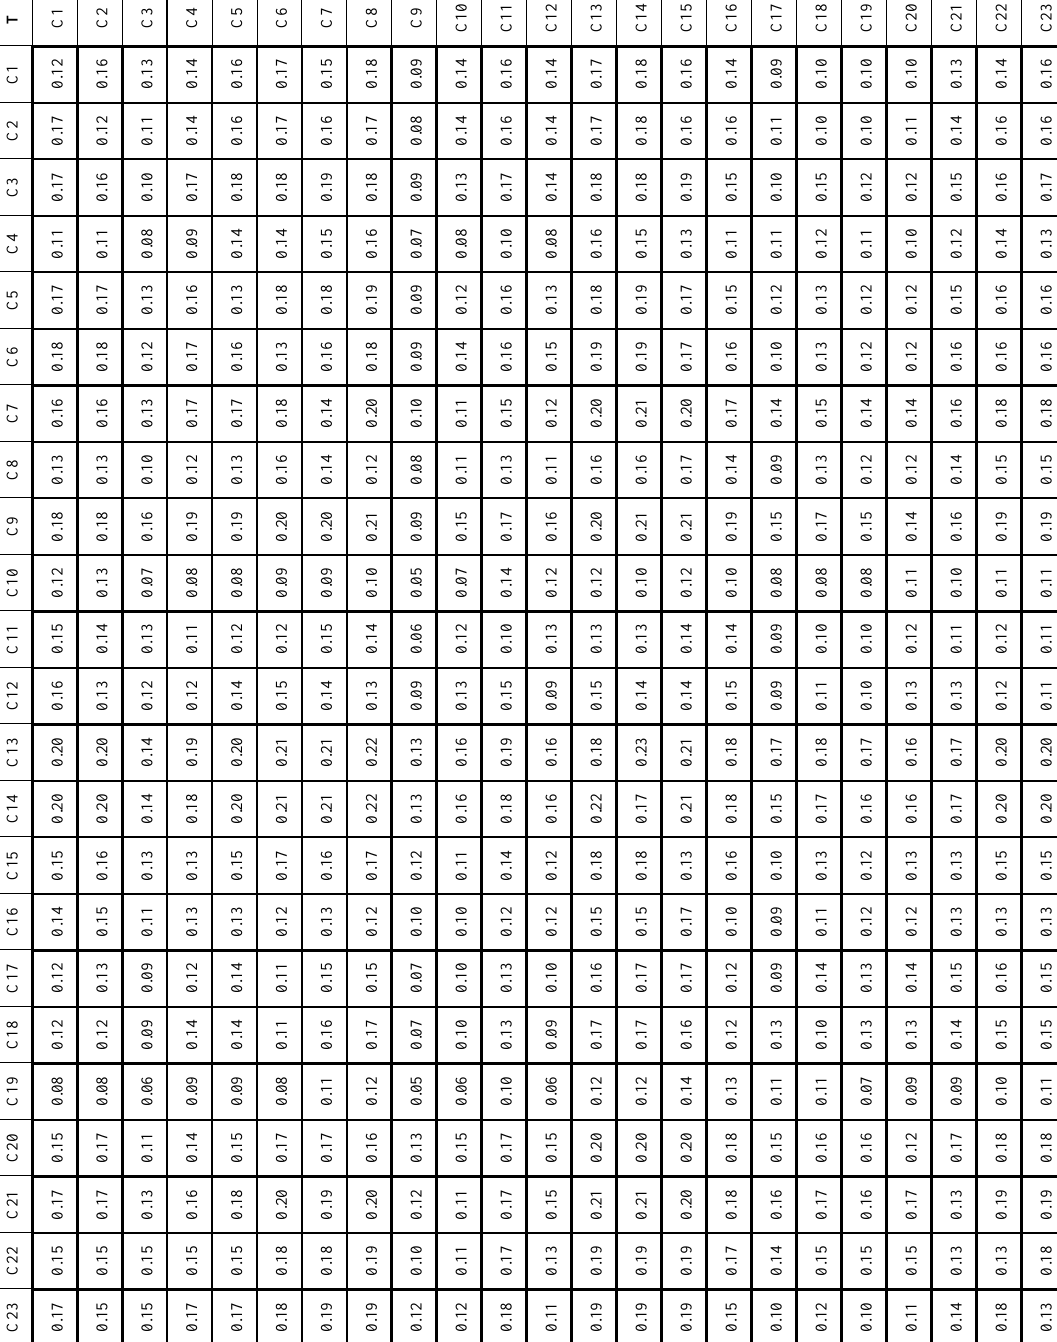
Table 14. Total relation matrix,